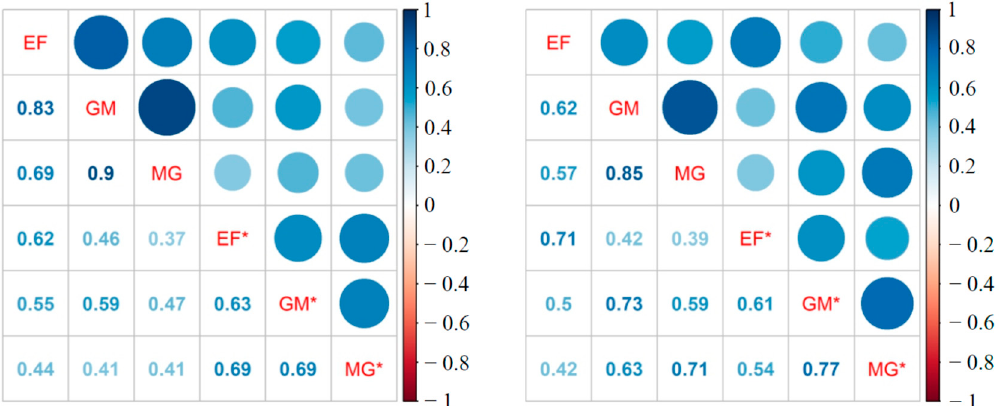
Figure 3. Pearson correlation between ASV classifications at the species level obtained from the Greengenes ( left ) and SILVA ( right ) libraries. The samples named “EF”, “GM” and “MG” correspond to 16S fragment databases (515–806); names with “*” refer to full-reference databases.